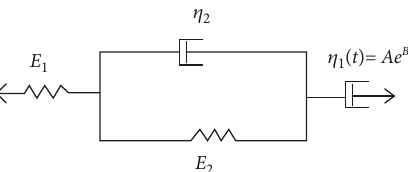
Figure 1: Modified Burgers model of four elements and five